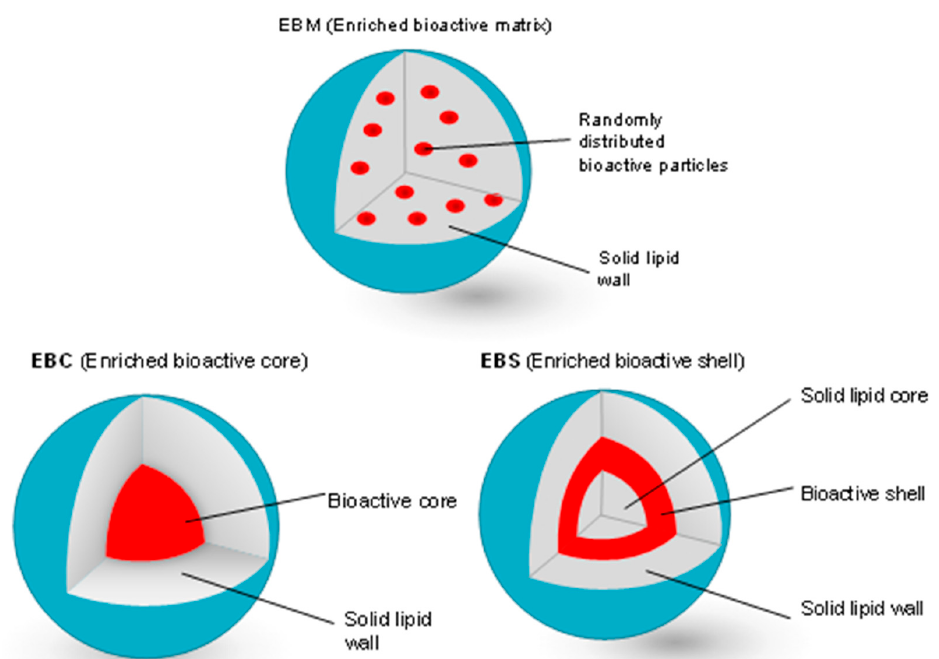
Figure 5. Three types of SLN. Enriched bioactive matrix (EBM), enriched bioactive core (EBC), and enriched bioactive shell (EBS).